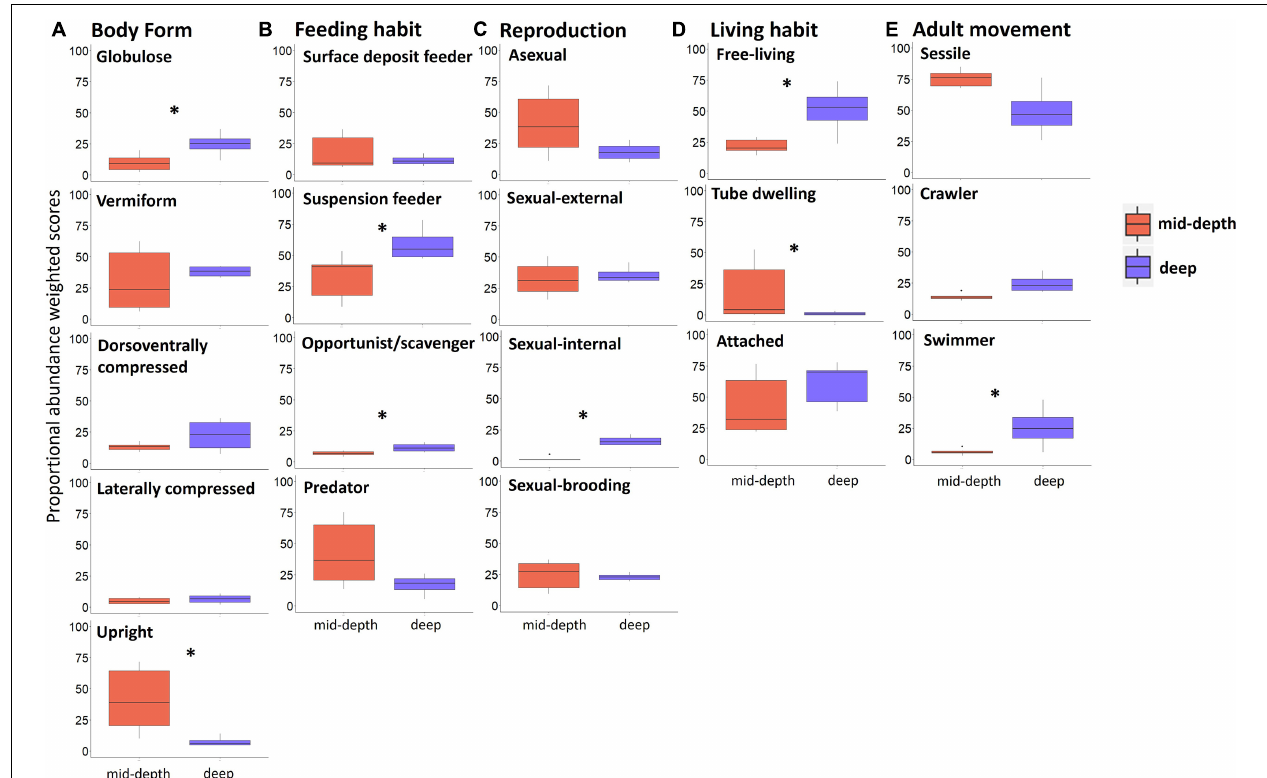
FIGURE 4 | Boxplots comparing modalities of different traits (weighted by proportional abundance) for mid-depth (in red) and deep stations (in blue) based on ROV samples of epifauna from the Chukchi Borderland; (A) body form, (B) feeding habit, (C) reproduction, (D) living habit, and (E) adult movement. Note traits with significant difference between depth strata and traits contributing most to variability among stations based on the Fuzzy Correspondence Analysis results are shown; modalities of these traits with low proportional abundance are not shown. Asterisks indicate significant difference between mid-depth and deep stations ( p < 0.05, Kruskal–Wallis test). Trait modalities are defined in Table 2